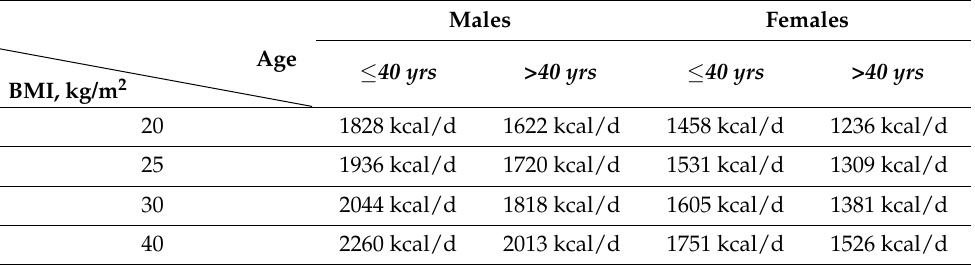
Table 4. Resting energy expenditure of the 2021 Reference Body for males and females according to BMI categories, sex and age (of <40 yrs and >40 yrs ). See Methods or details for the ‘Kiel study population’ and the calculation of the data. Males